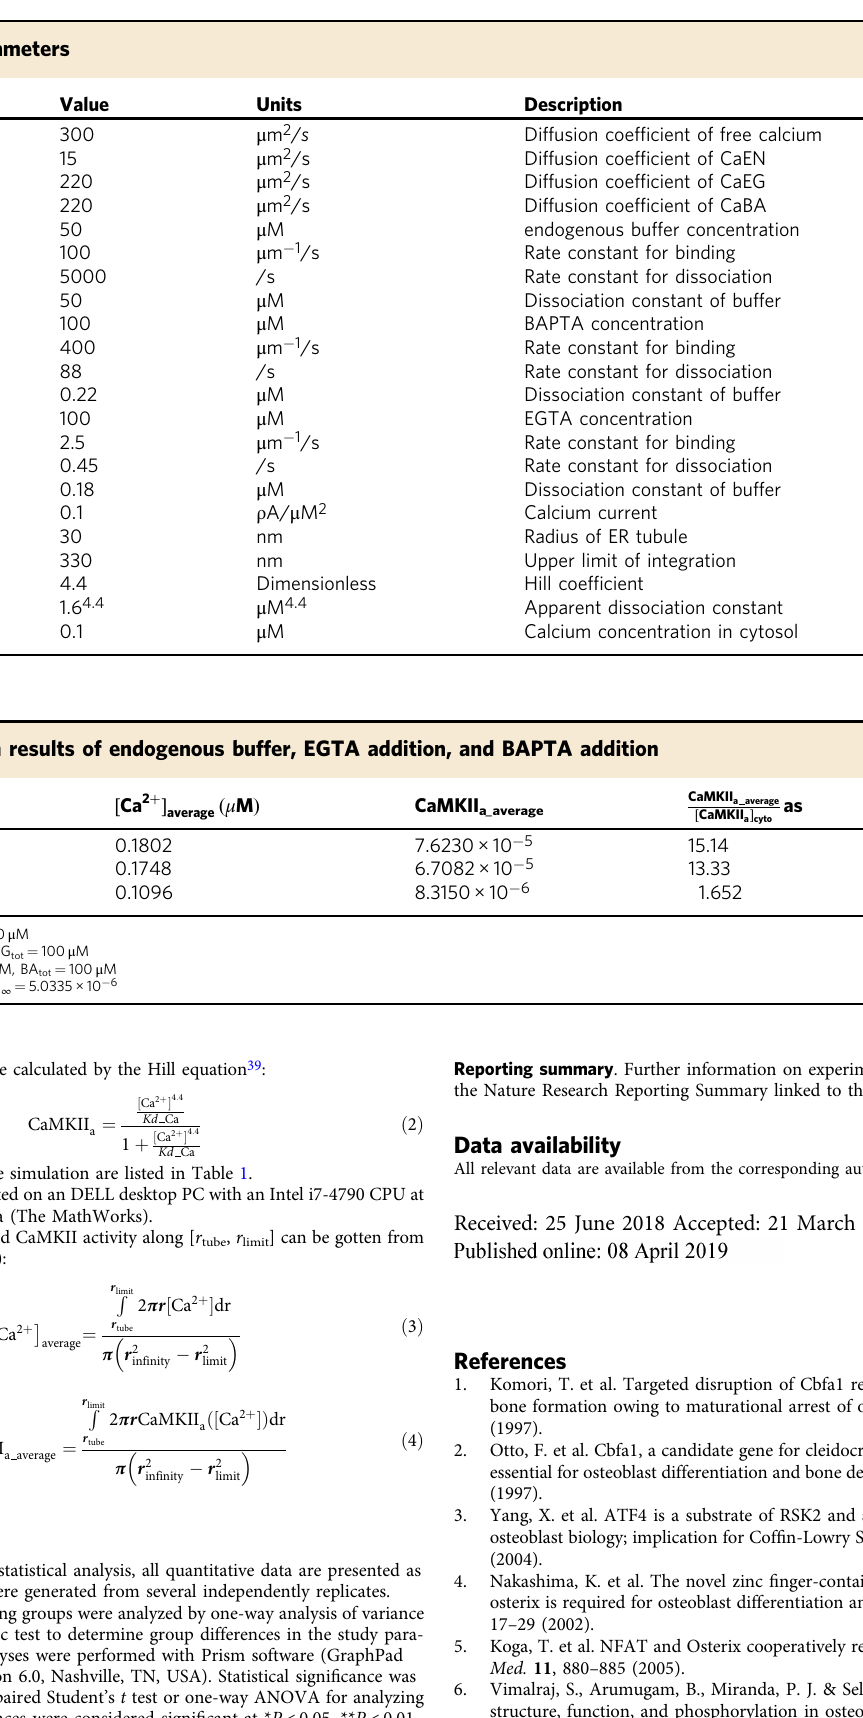
Table 1 Model parameters Parameters